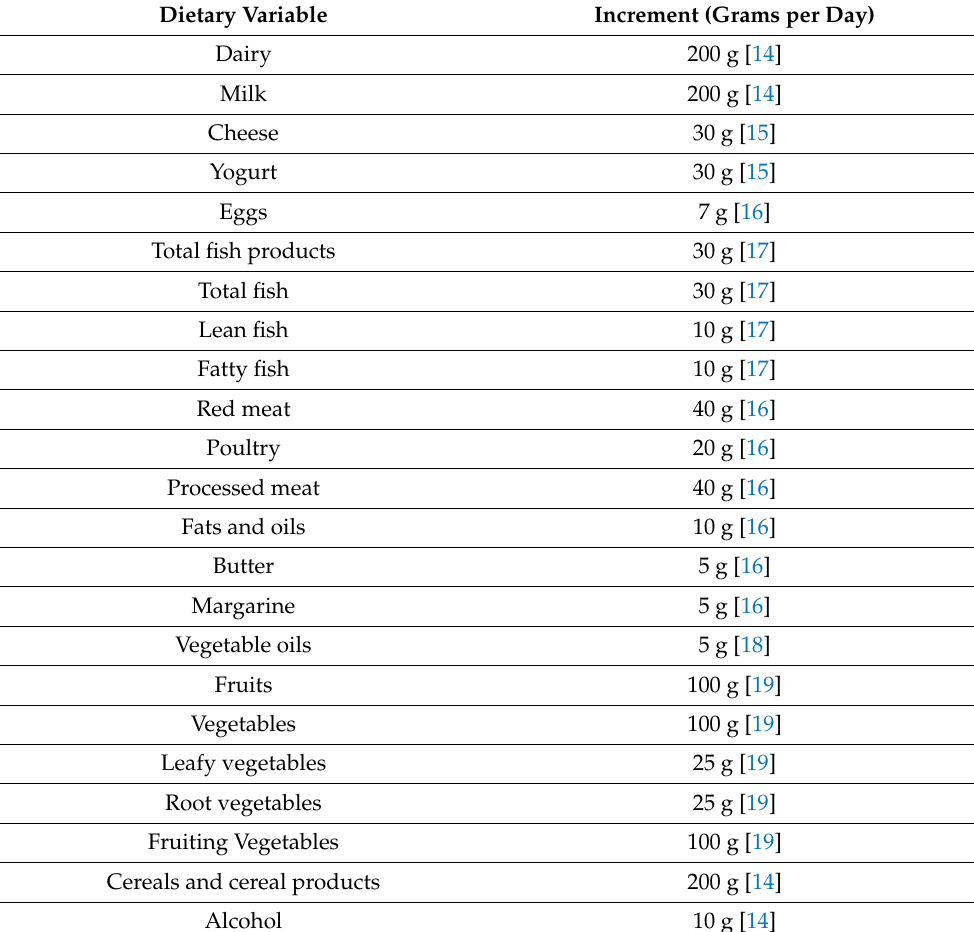
Table 1. Increments for each dietary